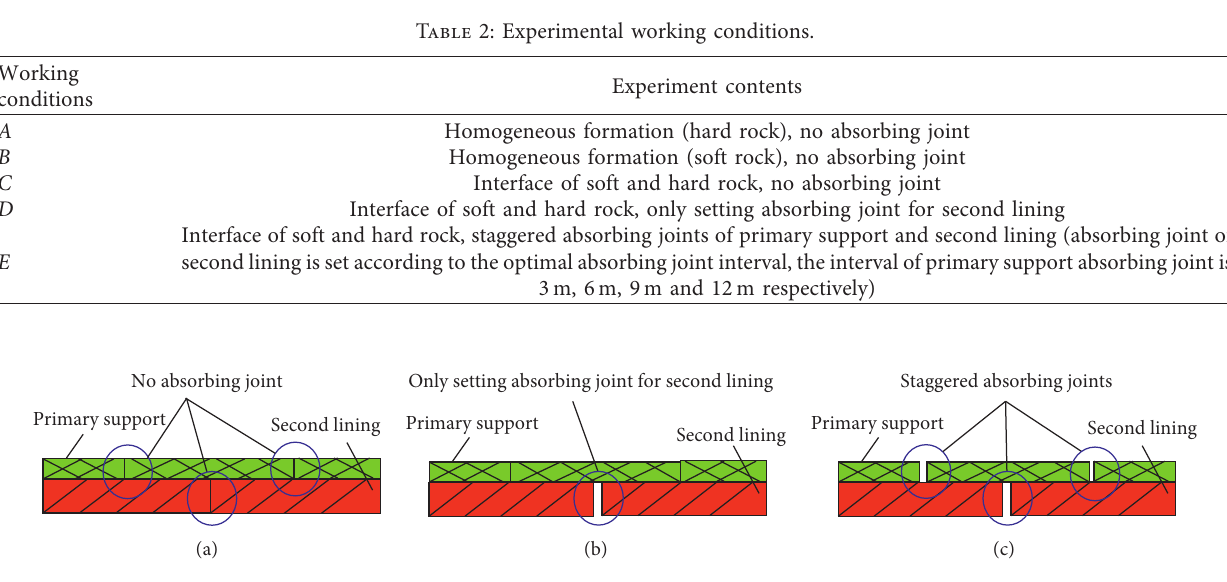
Figure 2: Setting of different absorbing joints. (a) Working condition C . (b) Working condition D . (c) Working condition E .